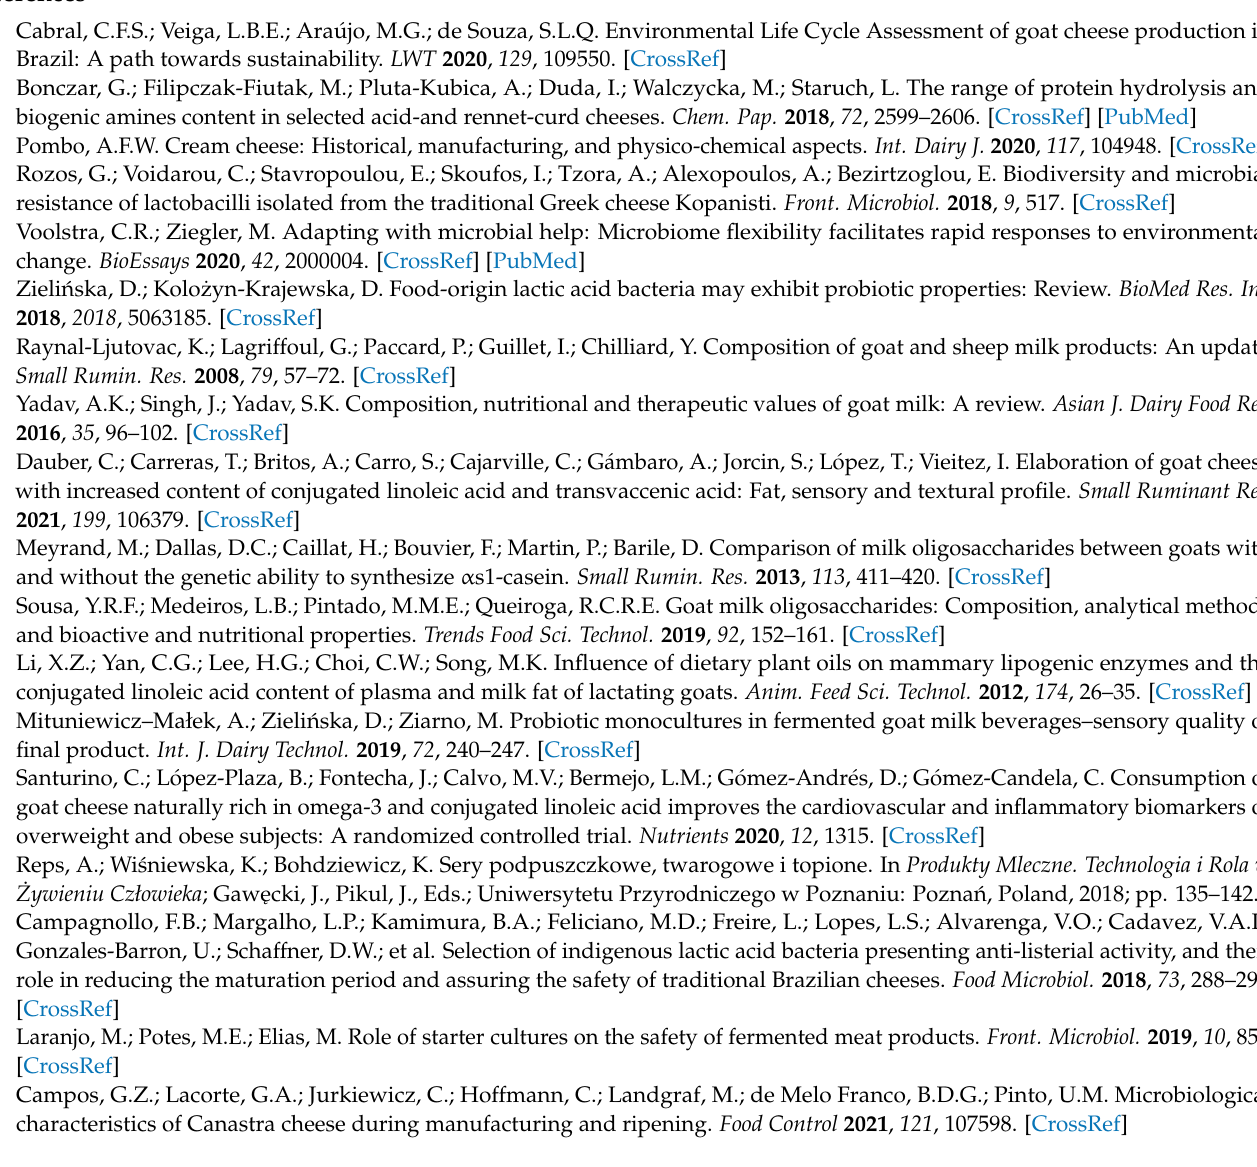
Explanatory: AW—goat’s cheese with acid whey, B1—goat’s cheese with L. brevis B1, Os2—goat’s cheese with L. plantarum Os2; LQI—Lipid Quality Indices; AI—Index of atherogenicity, TI—Index of thrombogenicity, DFA— Hypocholesterolemic fatty acids, OFA—Hypercholesterolemic fatty acids, H/H—The ratio of hypocholesterolemic and hypercholesterolemic fatty acids; HPI—Health-promoting index. The values were expressed as means ± SD; means in the same row followed by different uppercase letters within the same sample at different times are significantly different ( p < 0.05); means in the same column followed by different lowercase letters within samples at the same time are significantly different ( p < 0.05) (n =